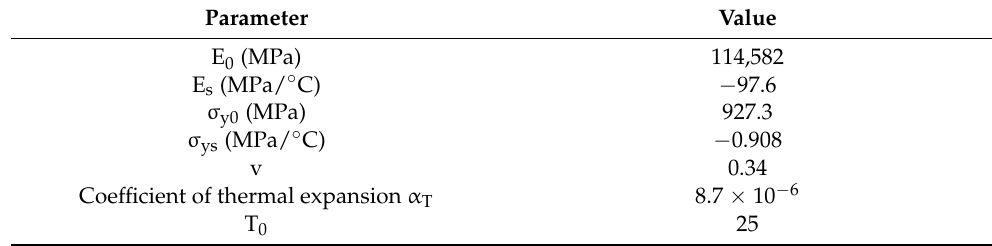
Table 1. Ti-6Al-4V material parameters [35].